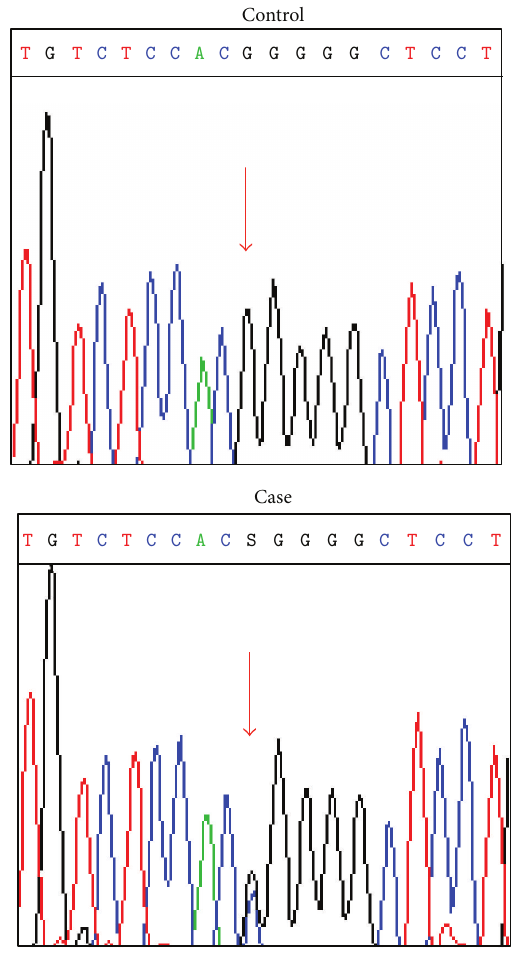
Figure 2: The mutation analysis of the NOTCH3 gene. The sequence analysis showed a missense mutation, GGG to CGG at the nucleotide 4039 of exon 24 (arrow). The DNA mutation numbering is based on the cDNA sequence (GenBank accession number NM 000435.2), with +1 corresponding to the A of the translational initiation